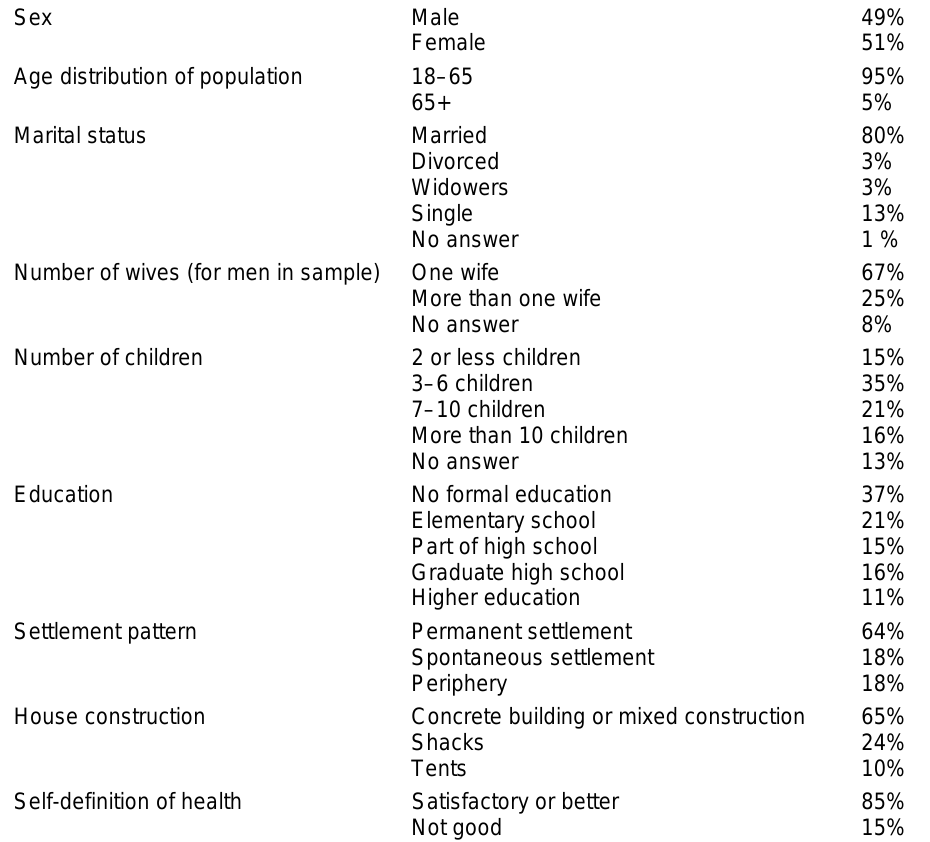
Characteristics of the Sample (n = 515 Head of